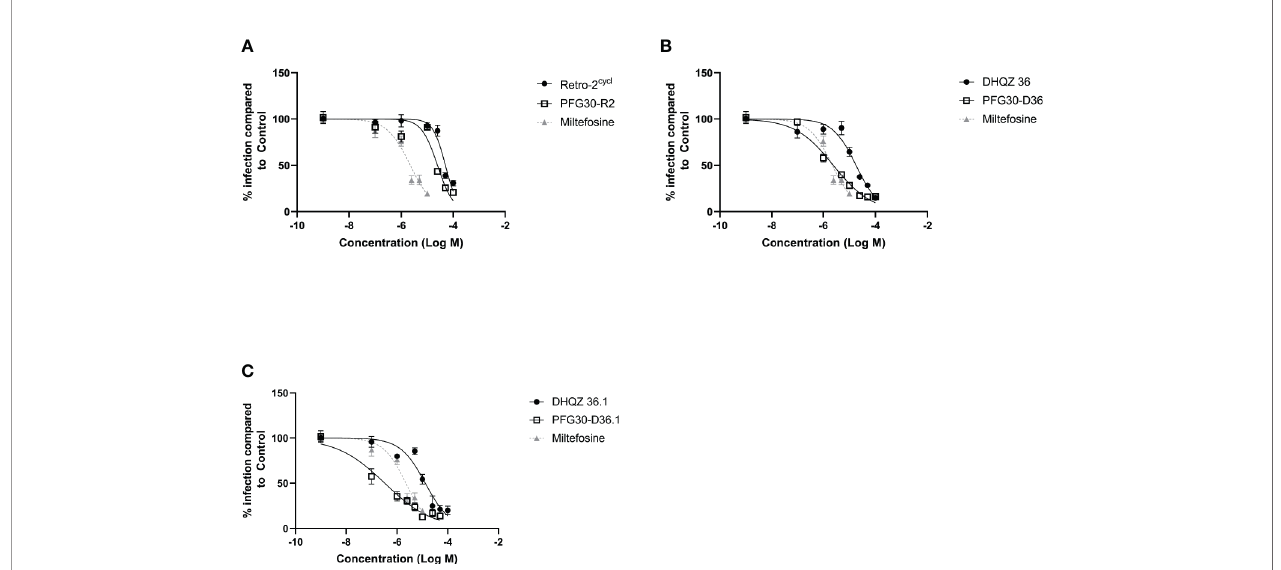
FIGURE 4 | Evaluation of polymer-encapsulated compounds on L. amazonensis -infected RAW264.7 macrophages. To L. amazonensis -infected RAW264.7 macrophages, the following drug/polymer mixtures were added then incubated for an additional 48 h. (A) Retro-2 in DMSO or Retro-2 + PFG30; (B) DHQZ 36 in DMSO or DHQZ 36 + PFG30; (C) DHQZ 36.1 in DMSO or DHQZ 36.1 + PFG30 at concentrations of 100 nM to 100 m M. Miltefosine (100 nM to 15 m M) treatment served as a positive control for parasite clearance. Cells were fi xed in 2% PFA in PBS. IFAs were performed for detection of LAMP-1 and cell and parasite nuclei with DAPI. At least 200 cells were scored per coverslip and infection rates were standardized to a vehicle control before EC 50 estimation. Data were compiled from at least three biological